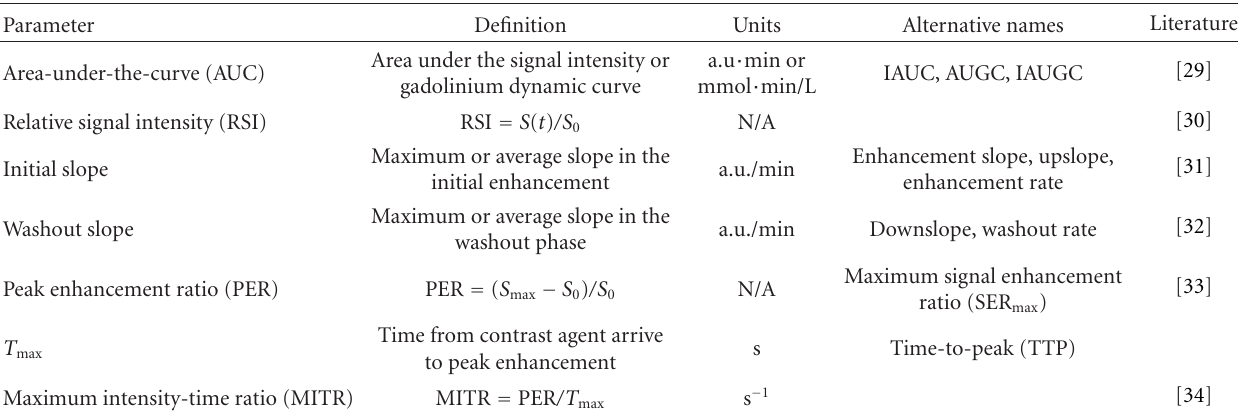
Table 2: Model-free parameters often used for DCE-MRI dynamic curve description †